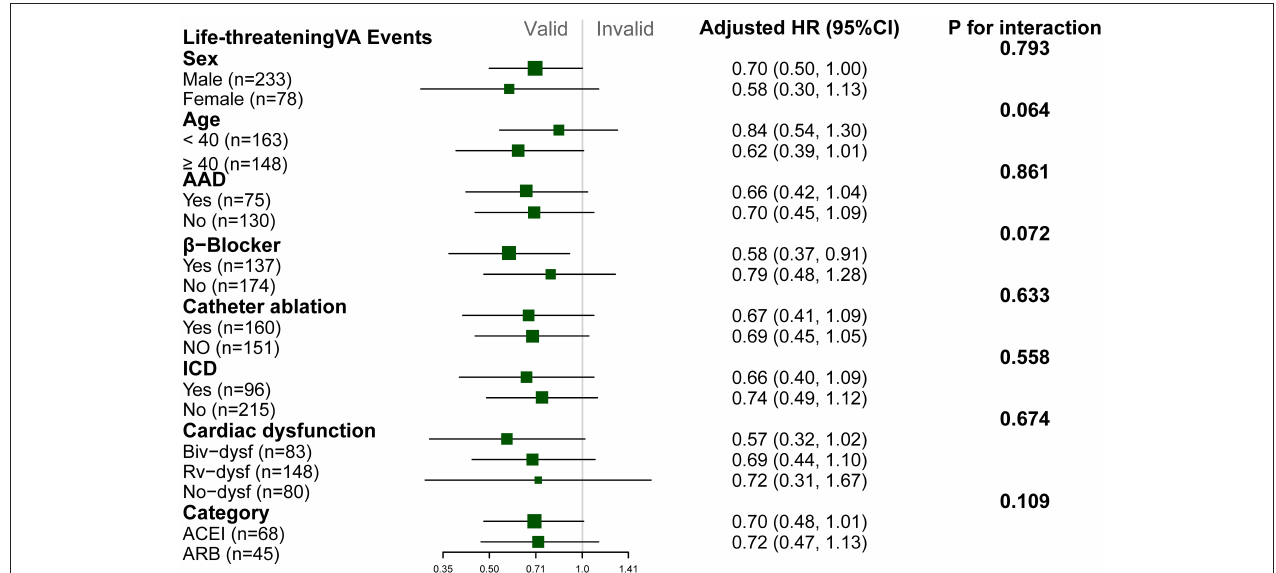
FIGURE 3 | Subgroup analyses of the association between ACEI/ARB and recurrence of life threatening ventricular arrhythmia. Hazard ratio (HR) and p -values were calculated using a Cox proportional hazard model. All subgroup analyses were adjusted for Model I (right ventricular ejection fraction [baseline], N-terminal pro-brain natriuretic peptide, percentage of late gadolinium enhancement in right ventricle, catheter ablation, implanted cardiac defibrillator). No variable interacted with ACEI/ARB. NSVT, non-sustained ventricular tachycardia; PVC, premature ventricular complex; Biv-dysf, bi-ventricular dysfunction; Rv-dysf, right ventricular dysfunction; No-dysfunction, no ventricular dysfunction; ACEI, angiotensin-converting enzyme inhibitor; ARB, angiotensin receptor blocker.